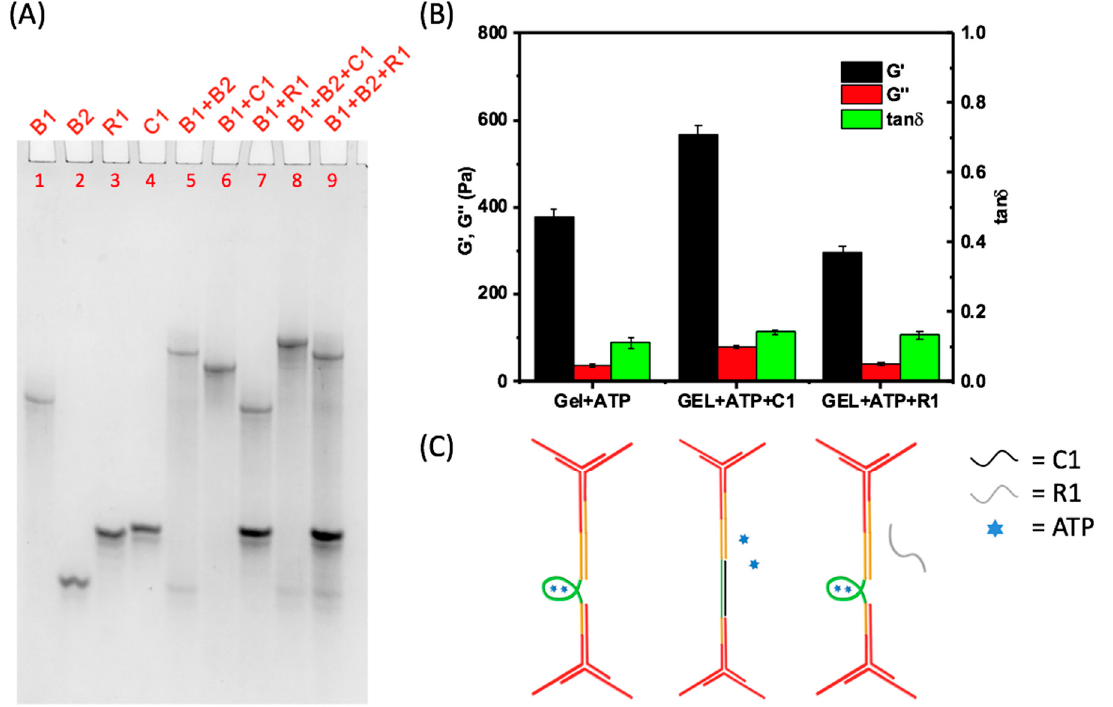
Figure 4. Further tuning the mechanical strength of DNA hydrogels by adding an ssDNA complementary to the aptamer sequence. ( A ) Characterization of C1B1 structure by 20% native PAGE. Four bands of ssDNAs B1 ( Lane 1 ), B2 ( Lane 2 ), R3 ( Lane 3 ), and C1 ( Lane 4 ) are clear. C1 can form structure with B1 with ( Lane 6 ) or without B2 (Lane 8 ), while R1 cannot hybridize with B1 ( Lane 7 and Lane 9 ); ( B ) Study of mechanical properties of the DNA hydrogel on adding ssDNA C1 and R1. All the measurements were carried out three times to get the average and statistical analysis was applied to get the error bar; and ( C ) Illustration of microscopic conformation transition of the aptamer sequence on adding ssDNA C1 and R1.